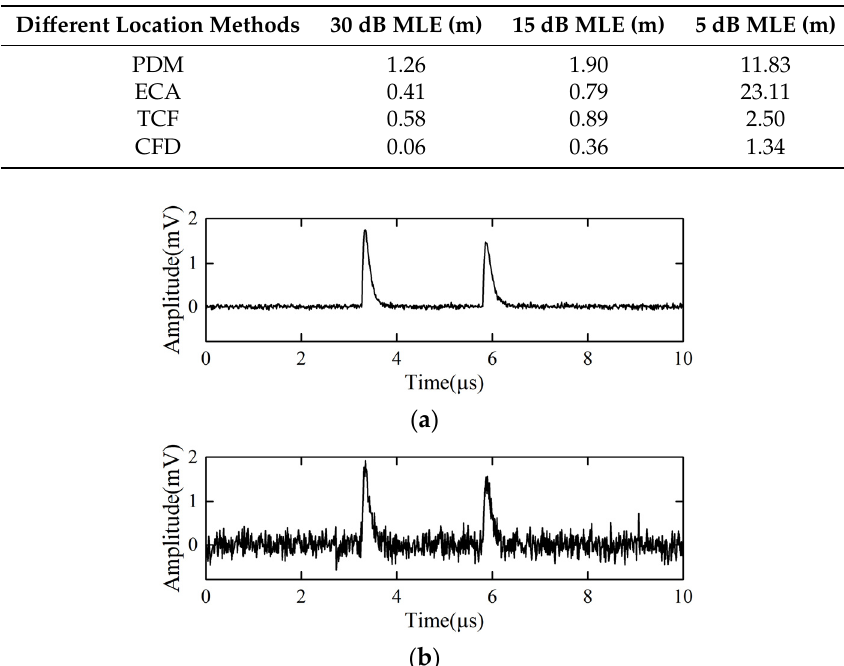
Figure 10. The time domain waveforms of the simulated PD pulse with different SNRs. ( a ) 30 dB; ( b ) 15 dB; ( c ) 5 dB.